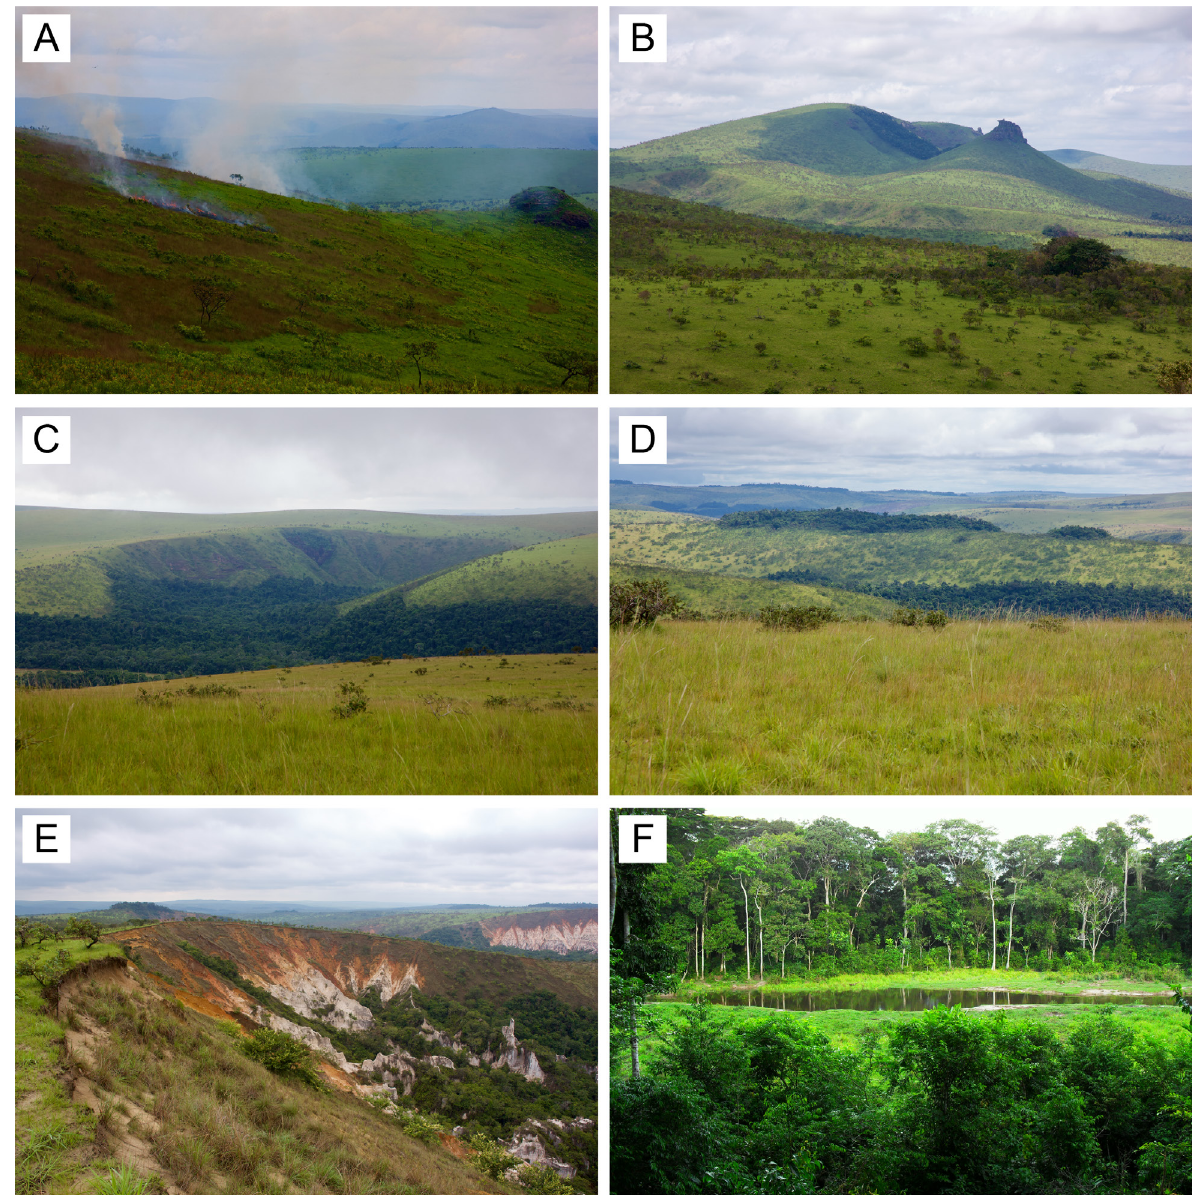
Figure 2. The Plateaux Batéké landscape. A . Customary fire in the savanna near Kele la Tsiere. B . Kele la Kalami (Mont Kalami), a sacred site and the highest point in the study site at 700 m. C . Riparian forest. D . Abandoned village forests within the savanna. E . Cirque. F . Mopia Bai, from the major forest block. All photos were taken by Gretchen